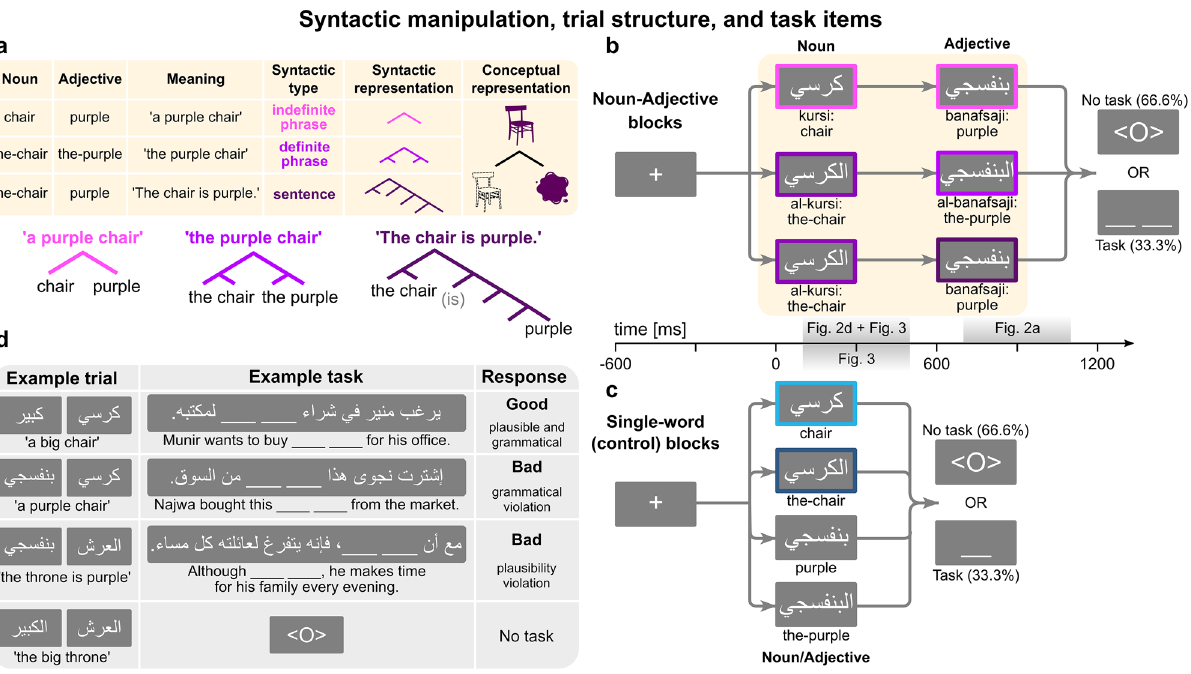
Figure 1. Syntactic manipulation and trial structure. ( a ) The three-way syntactic manipulation. Syntactic representation column shows schematic structure per condition; detailed schematic structures appear below the table. ( b ) Trial structure in noun-adjective blocks. Highlighted areas on time axis indicate time window of analyses, and the corresponding figure numbers. Colors correspond to those used in Figs. 2 and 3. ( c ) Trial structure of single-word control blocks. ( d ) Example task